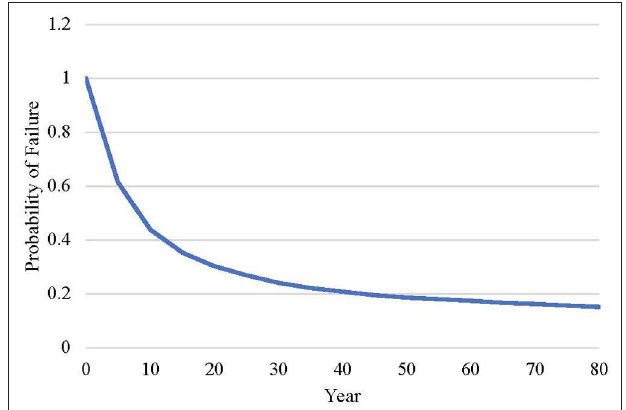
FIGURE 6 | Simulation based probability of failure at 5 year intervals for a 0.04 m design with a water-to-cement ratio of 0.45 and a 0.08 m design with a water-to-cement ratio of 0.40.